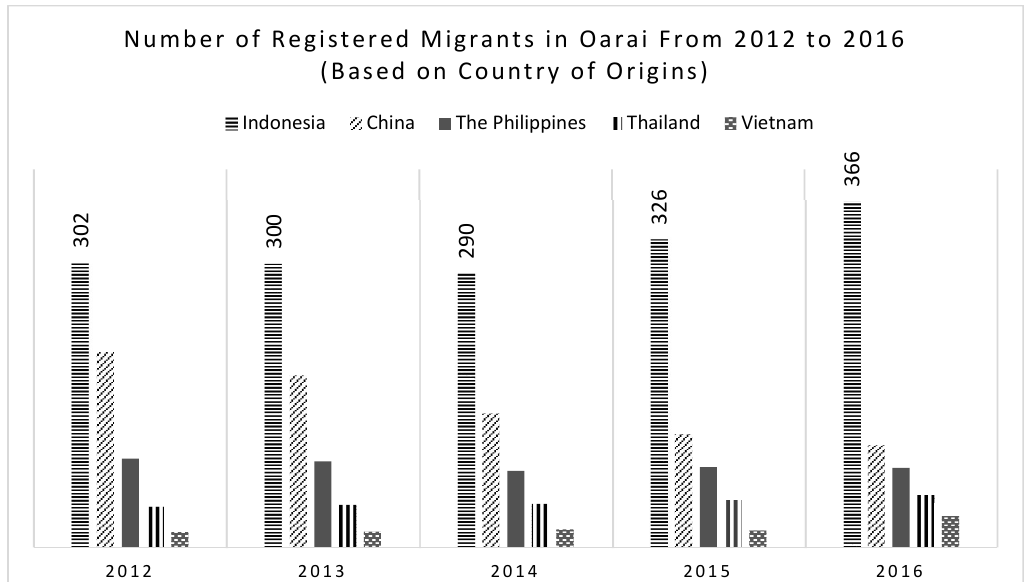
Figure 2. Number of registered migrants in Oarai from 2012 to 2016 by country of origin. (Data source: from a personal request to Oarai Town Office in 2018, graph by author.).